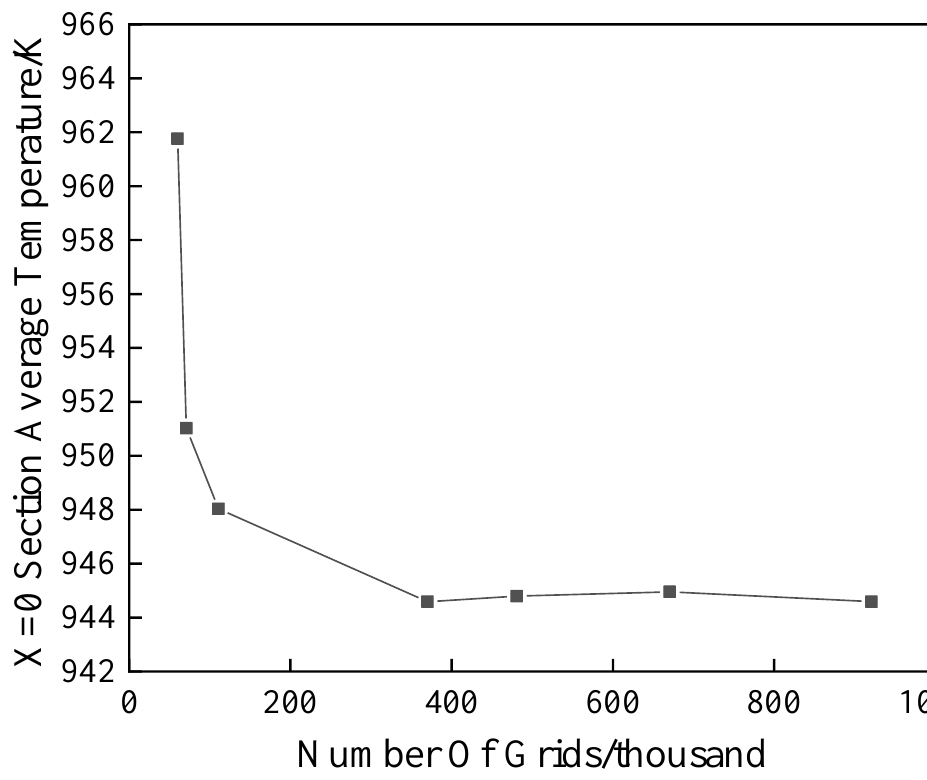
Figure 6. Grid independence verification.